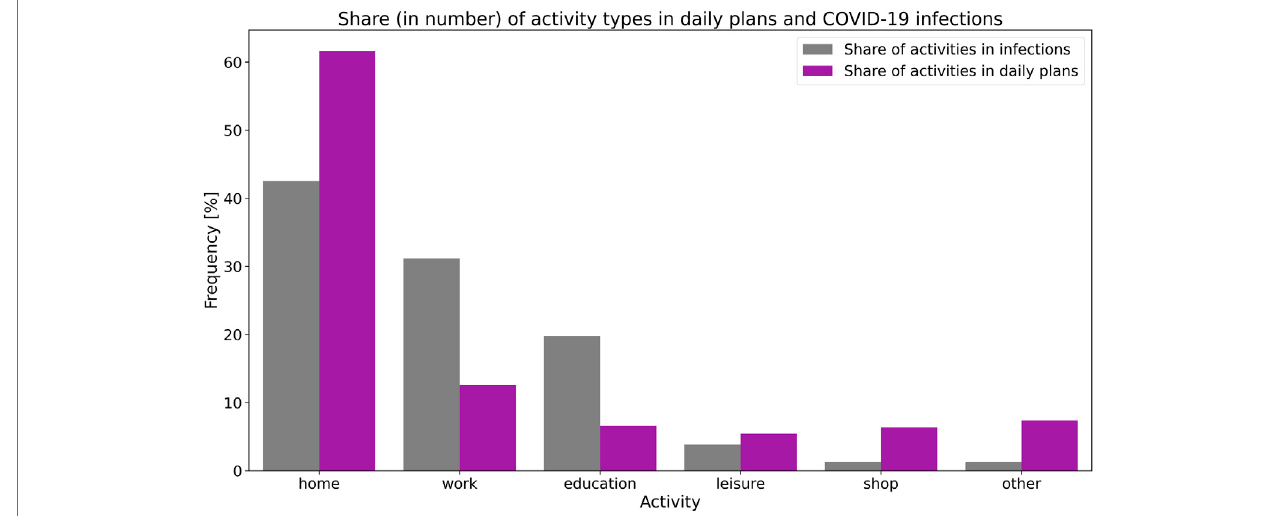
FIGURE 4 | Comparison between the share of daily activities in COVID-19 infections and in daily plans (frequency in terms of number/occurence).